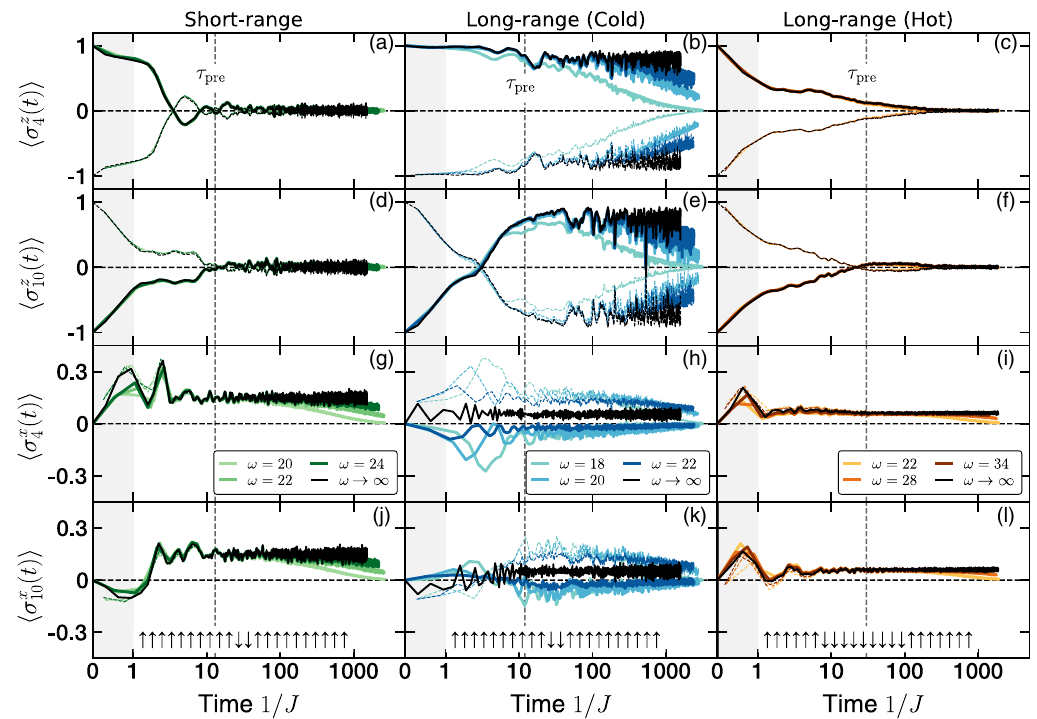
FIG. 6. Analysis of the evolution of different single spin operators — σ z 4 , σ z 10 , σ x 4 and σ x 10 — for the different conditions considered in Fig. 3: the short-range model (a),(d),(g),(j), a “ cold ” initial state in the long-range model (b),(e),(h),(k), and a “ hot ” initial state (e),(f),(i),(l). On the different single spin observables, we observe the approach to a position-independent constant within the prethermal regime, consistent with the plateau observed in the ω → ∞ limit Floquet evolution, further suggesting that the system has approached a thermal state of the prethermal Hamiltonian D (cid:2) . By increasing the frequency of the driven system, we observe this agreement extending to later time, highlighting that the disagreement occurs due to the late time heating which becomes meaningful τ (cid:2) ∼ e ω =J local . We also note that this simple picture is more complex in the case of σ x . In this case, one needs to account for the small frame rotation U which can induce a finite overlap between U σ x U † and an observable that fails to commute with X